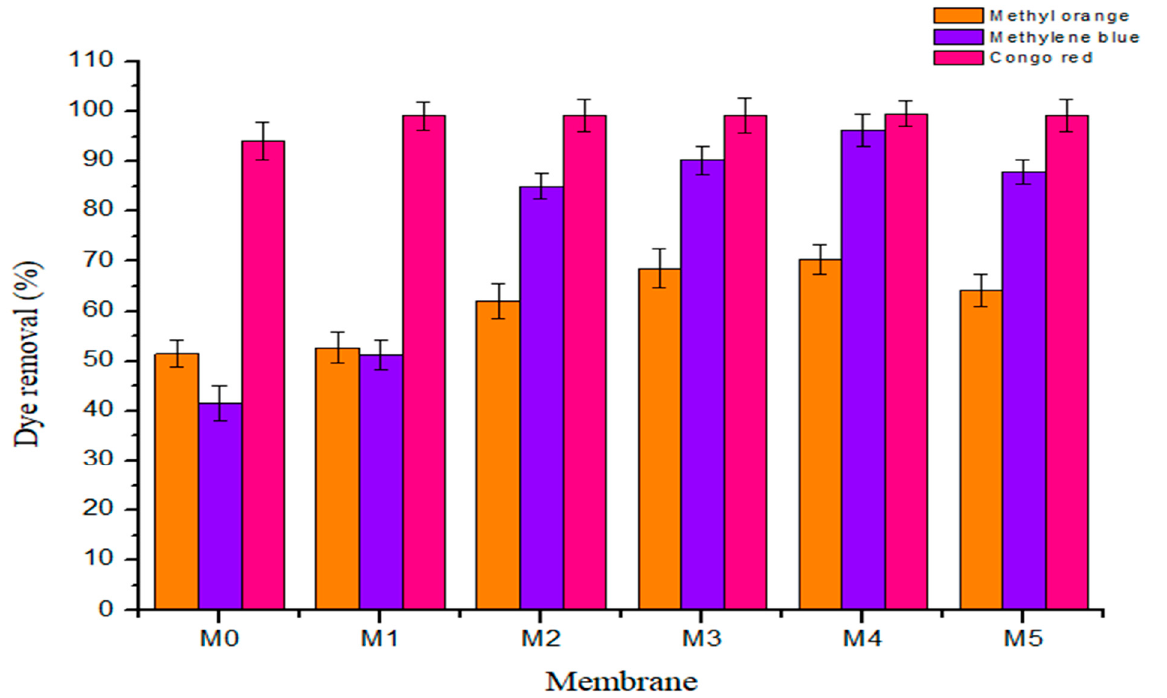
Figure 10. Rejection profile of the three heterocyclic aromatic dyes on fabricated membranes. Table 4. Rejection data of the three dyes on the fabricated membranes.